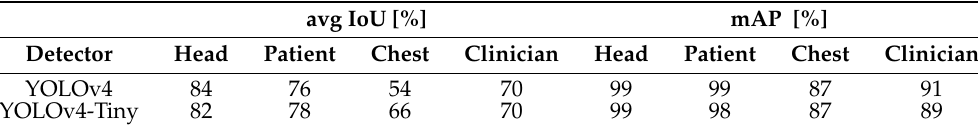
Table 4. Quantitative detection results on the test dataset (900 images).